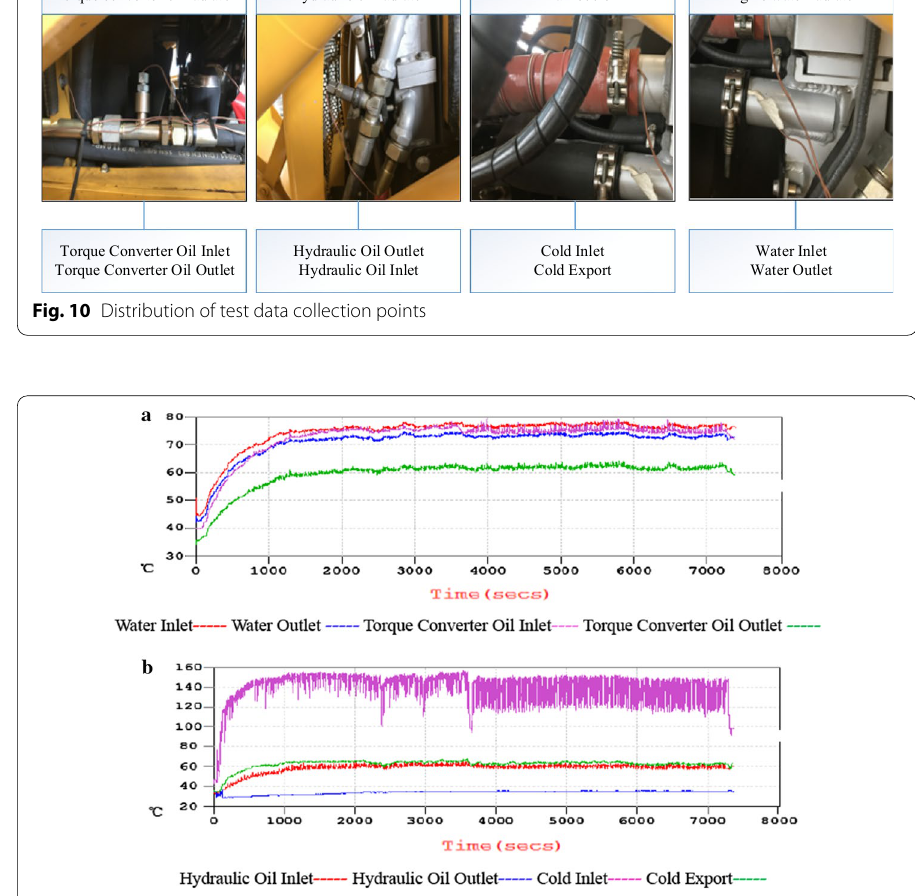
Fig. 11 Radiator group temperature curve at full speed driving